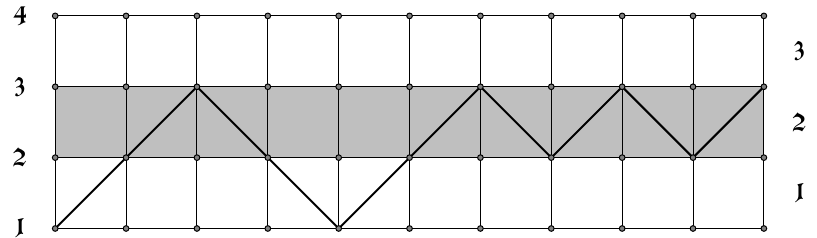
Figure 6 . A non-minimal path in the Lee-Yang restricted solid-on-solid model L 2 ; 5 , labeled by a = 1, b = 2, and c = 3, that contains a valley at ( x; y ) = (2 ; 2) of weight wt = 2 + 2 = 4.